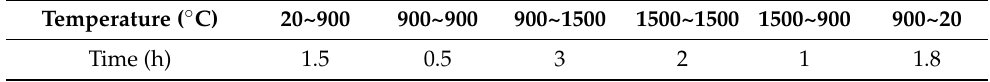
Table 2. The recommended sintering